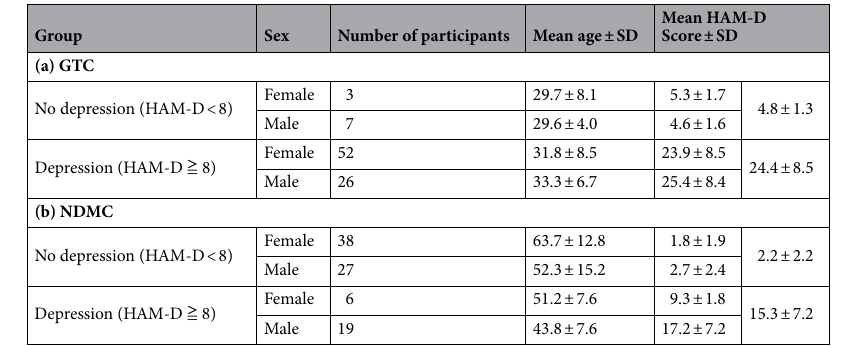
Table 3. Mean scores on the Hamilton Rating Scale for Depression